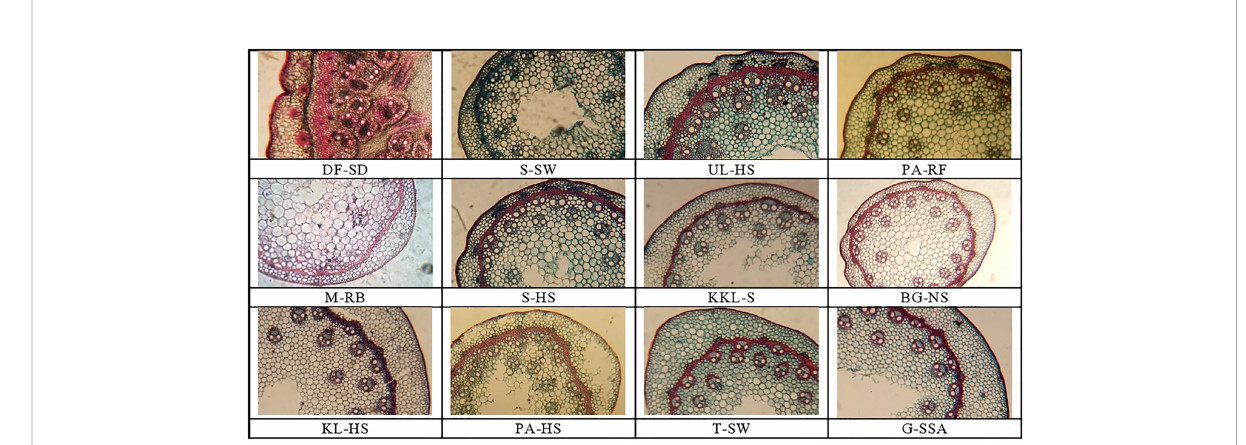
FIGURE 3 Stem tranverse sections of cynodon ecotypes collected from the Punjab, Pakistan. DF-SD, Derawar fort-saline dessert; M-RB, MUZAFFAR GARH-RIVER BANK; KL-HS, khabbeki lake-hyper saline; UL-HS,Ucchali Lake-Hyper Saline;KKL-S; Kalar Kahar Lake-Saline;T-SW,Treemu-Saline Wetland; S-SW, Sahianwala-Saline Wetland; S-SH, Sahianwala-Hyper Saline; PA-HS, Pakka Anna-Hyper Saline; PA-RF, Pakka Anna-Reclaimed Field; BG-NS, Botanic Garden-non saline; G-SSA, Gatwala-saline